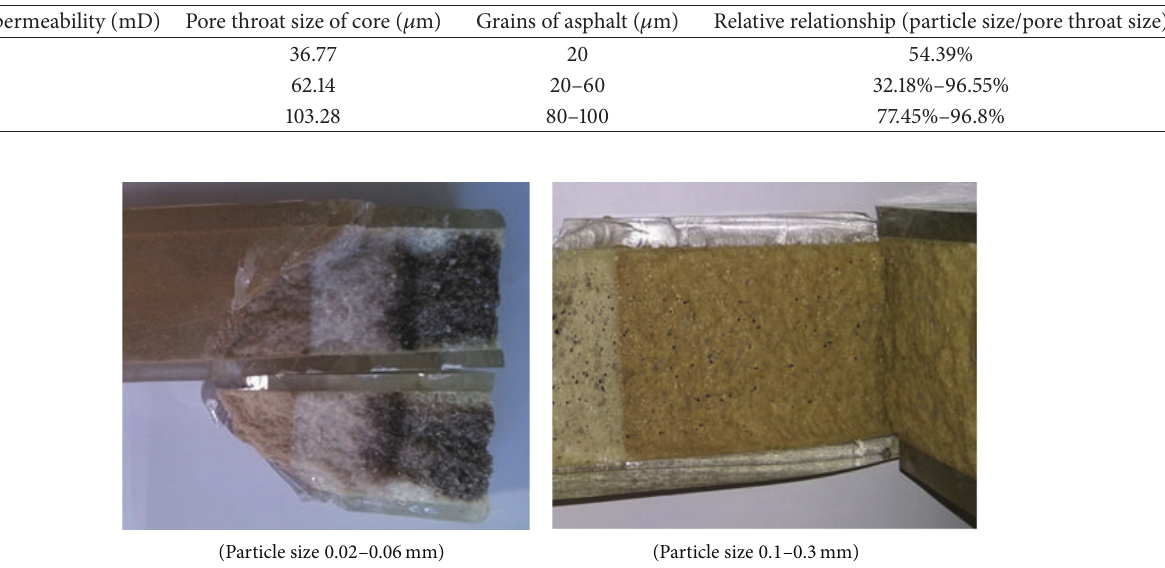
Figure 5: Core cleaving comparison chart.